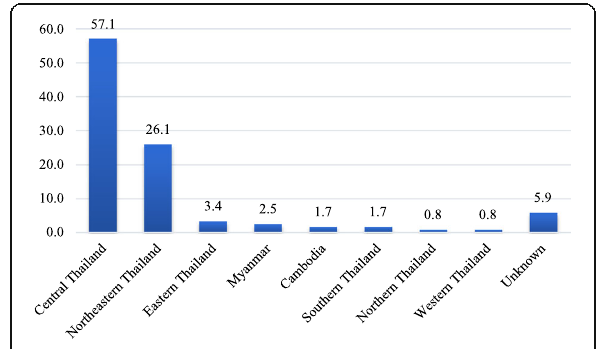
Fig. 3 Percent of birth place of